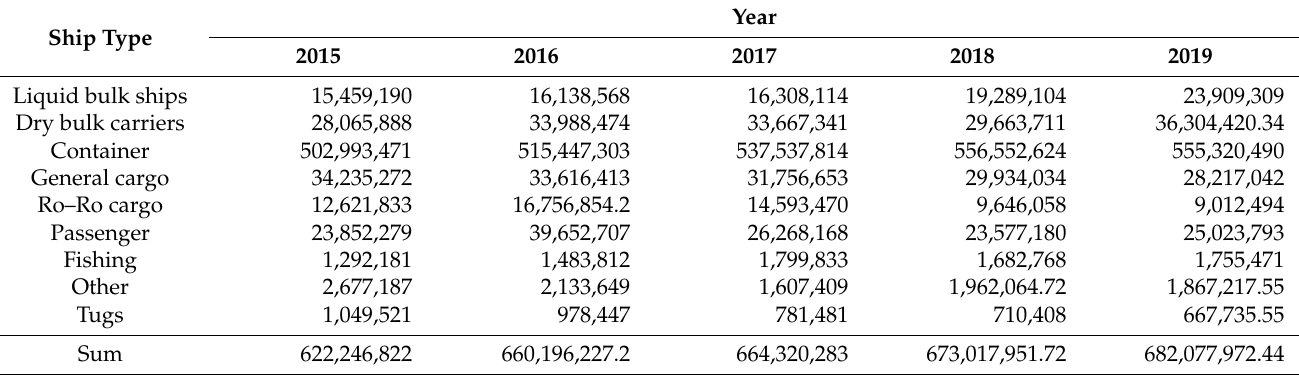
Table 9. Entry ship gross tonnage (GT) statistics 1 by ship type at Busan Port from 2015–2019